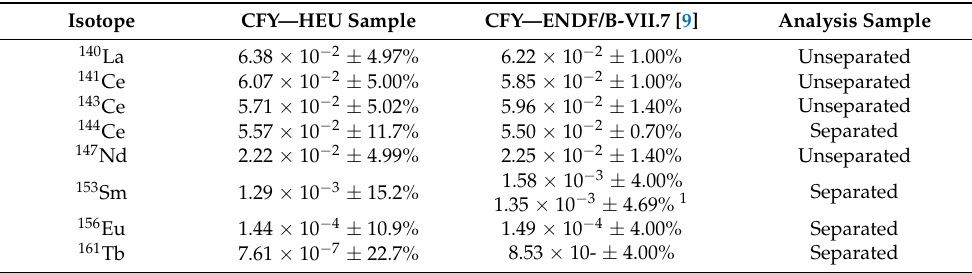
Table 7. Cumulative fission yields (CFY) of the lanthanides present in an irradiated HEU sample. Samples were run in quadruplicate, and error bars show 1 σ uncertainty.